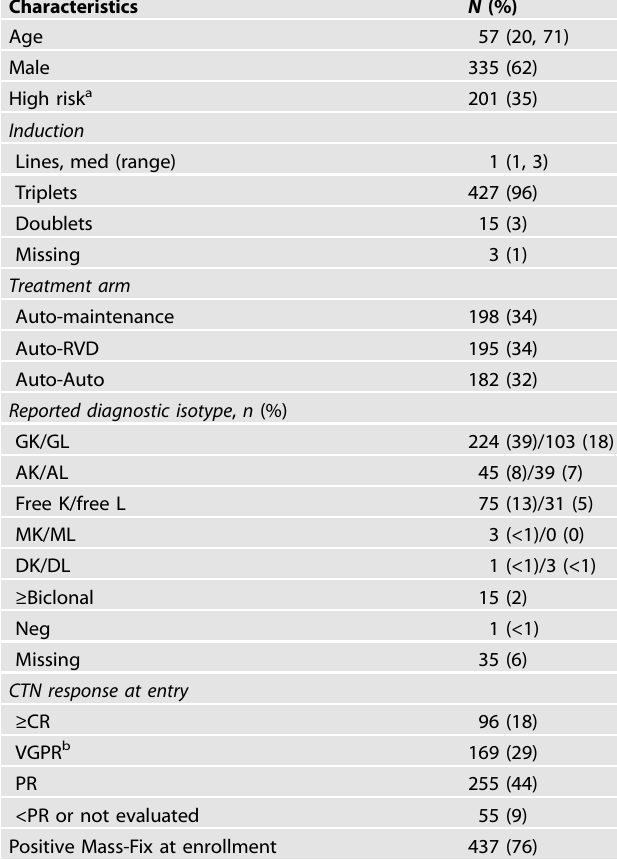
Table 1. Patient characteristics ( n =